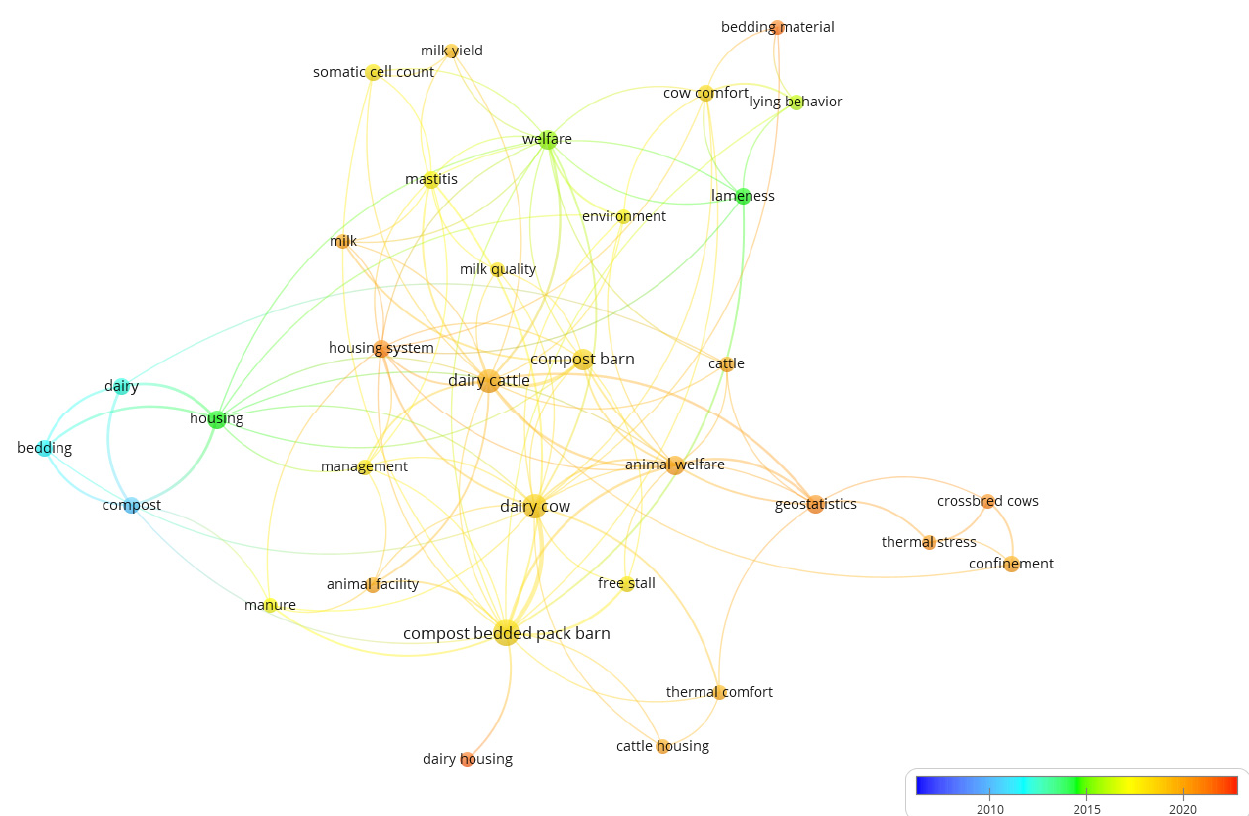
Figure 8. Map based on the co-occurrence of authors’ keywords and evolution from 2007 to 2022/April. The color scale represents the keyword’s year of dominance.